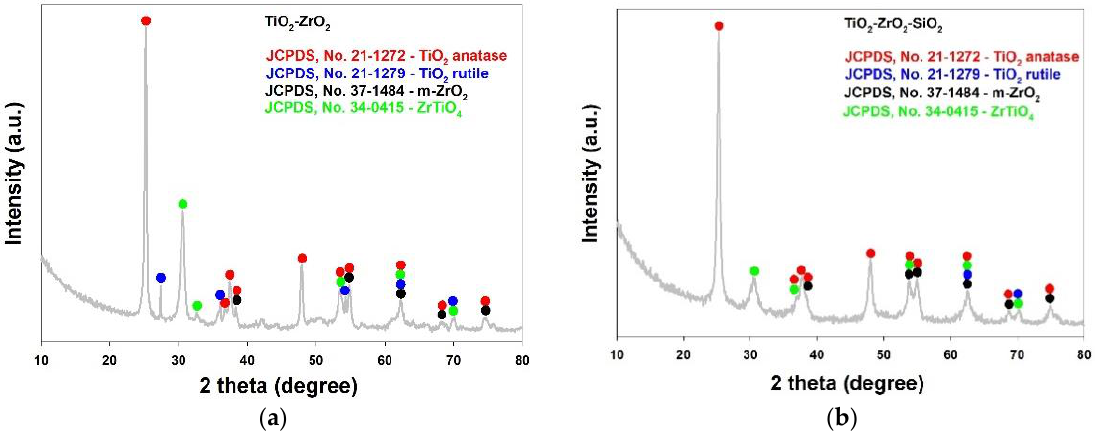
Figure 2. X-ray diffraction patterns of: ( a ) pure TiO 2 -ZrO 2 and ( b ) pure TiO 2 -ZrO 2 -SiO 2 .